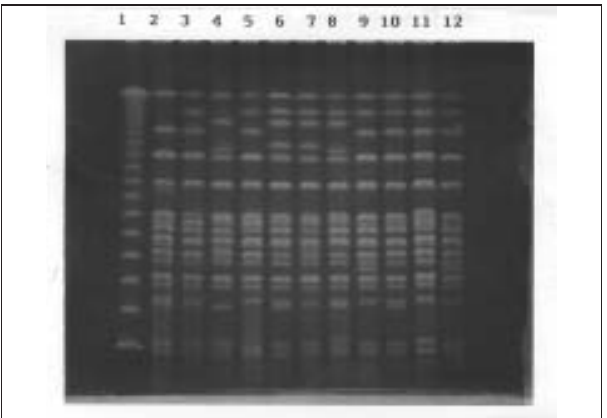
Figure 1) Genomic profiles of 11 randomly selected clinical isolates